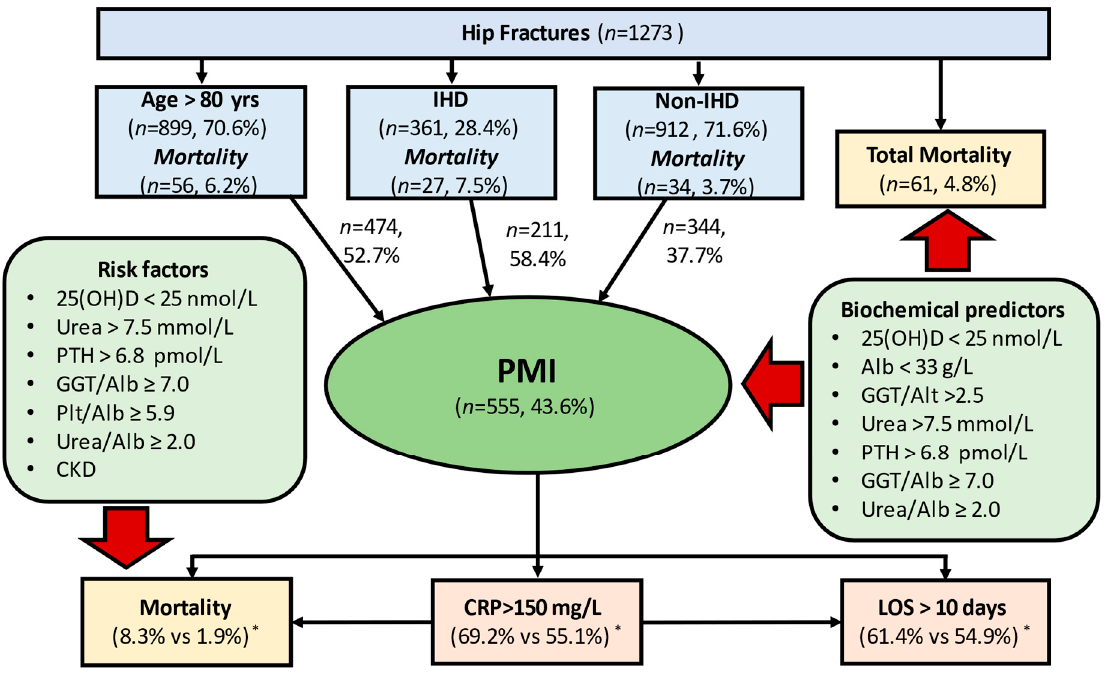
Figure 1. Relationships between ischaemic heart disease (IHD), postoperative myocardial injury (PMI), other adverse hospital outcomes and predictive biomarkers at admission in patients with hip fracture (HF). Among HF patients 70.6% were aged >80 years (mortality 6.2%), 28.4% have been diagnosed with IHD pre-fracture (mortality 7.5% vs. 3.7% in the non-IHD group); the total all-cause mortality 4.8%. PMI occurred in 43.6% of patients: in 58.6% among subjects with previously diagnosed IHD (11.1% had a history of AMI) and 37.7% in the non-IHD group. PMI developed in 52.7% of patients aged >80 years, in 58.4% of patients with pre-fracture known IHD, and in 37.7% of patients without IHD. PMI contributed to 80.3% (49 of 61 patients) of all deaths (mortality rate (8.8% vs.1.9% in non-PMI) and was associated with a higher frequency of a high postoperative inflammatory response (CRP > 150 mg/L after the 3rd postoperative day: 69.2% vs. 55.1%) and prolonged hospital stay (LOS > 10 days: 61.4% vs. 54.9%). On-admission biochemical predictors of PMI and/or a fatal outcome are shown in the box on the right. Factors at admission that significantly (1.3–1.6-times) increase the risk of a lethal outcome in patients who developed PMI are listed in the left box. * Comparison with non-PMI patients.